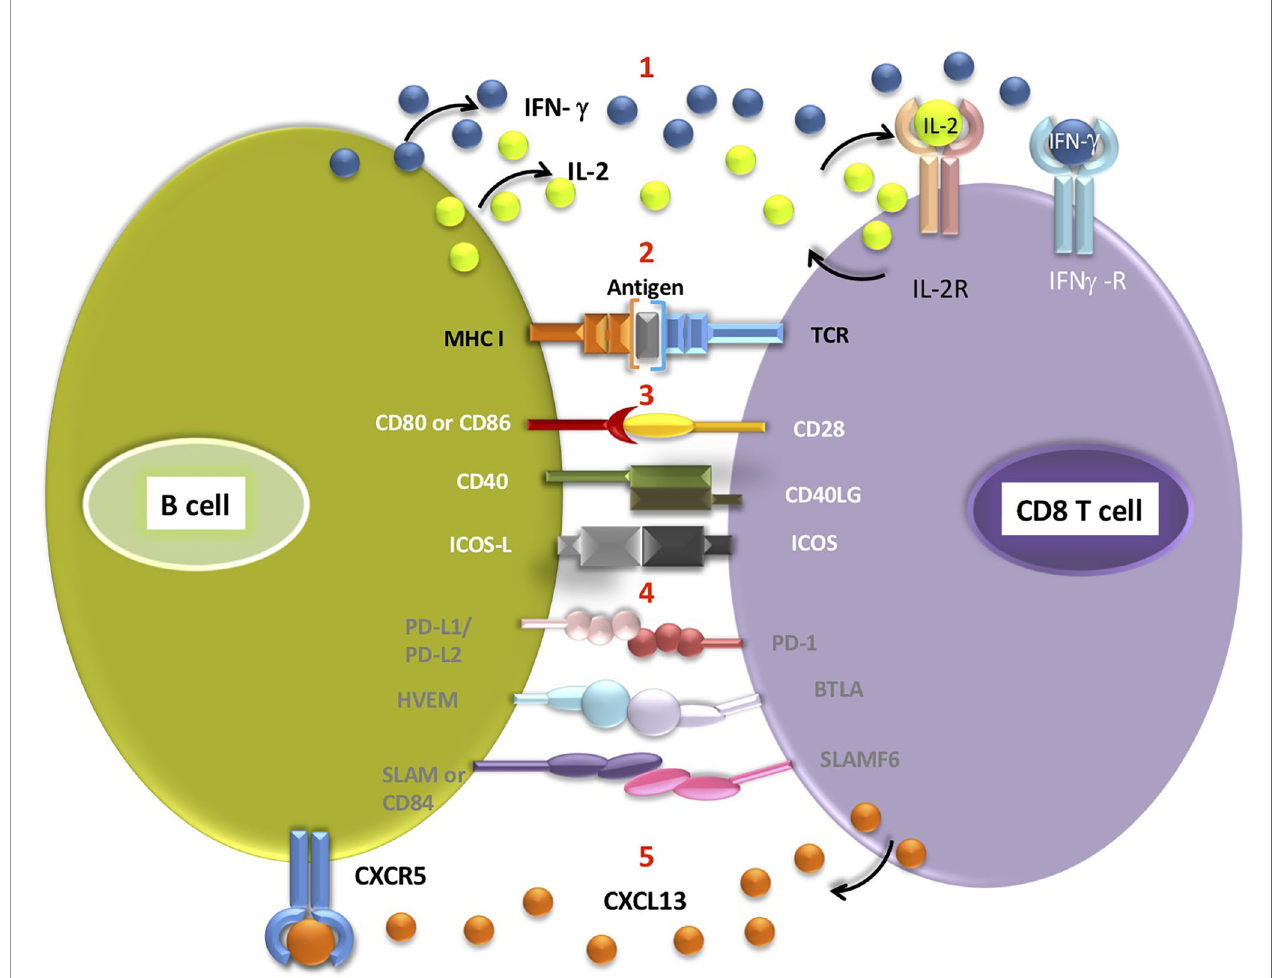
FIGURE 1 | Interactions potentially occurring between the B cell and CD8 T cells located in the TLS (1). B cells secrete cytokines such as IFN- g and IL-2, which can then bind to appropriate receptors on CD8 T cells (2). Antigen presentation on MHC class I molecule expressed by B cell triggers signalling from TCR receptor on T cell. Engagement of receptors on B cells and corresponding T cell receptors delivers co-stimulatory (3, white font) or co-inhibitory (4, grey font) signals to T cells (5). CD8 T cells secrete CXCL13, a B-cell chemoattractant which binds to CXCR5 receptors on B cells. Antigen cross-presentation by intratumoral B cells requires further experimental